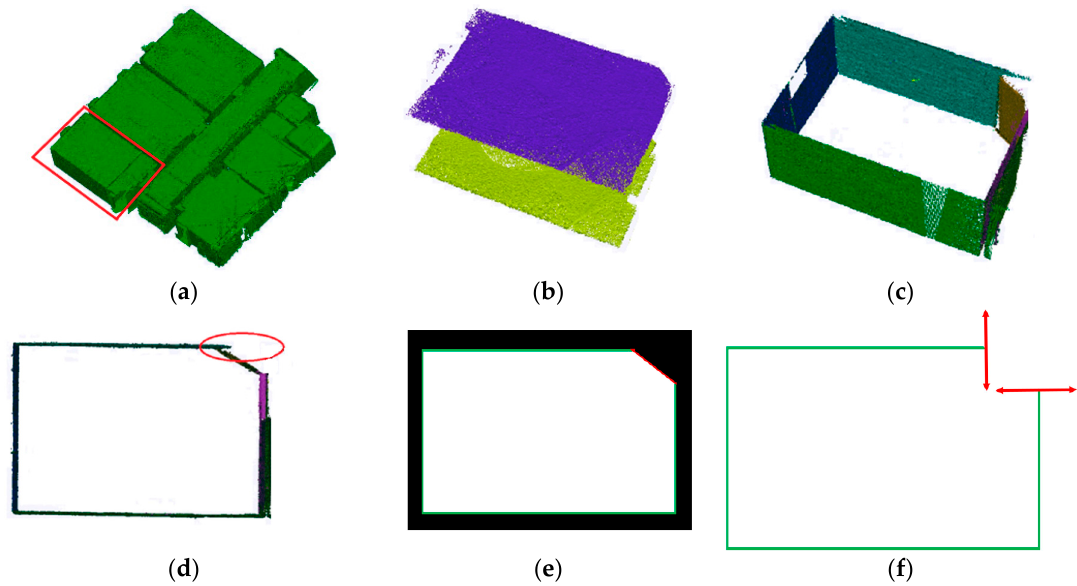
Figure 3. Detection of room surface: ( a ) localization of the room addressed in this example; ( b ) planar elements classified as ceiling (purple) and floor (sand); ( c ) possible wall surfaces; ( d ) a wall portion is missing (red circle) due to occlusions, ( e ) occupancy map of the ceiling with real walls (green segments) and spurious boundaries (red segments) for Room 1, ( f ) detected primitives (green) and guessed ‘pending’ walls.